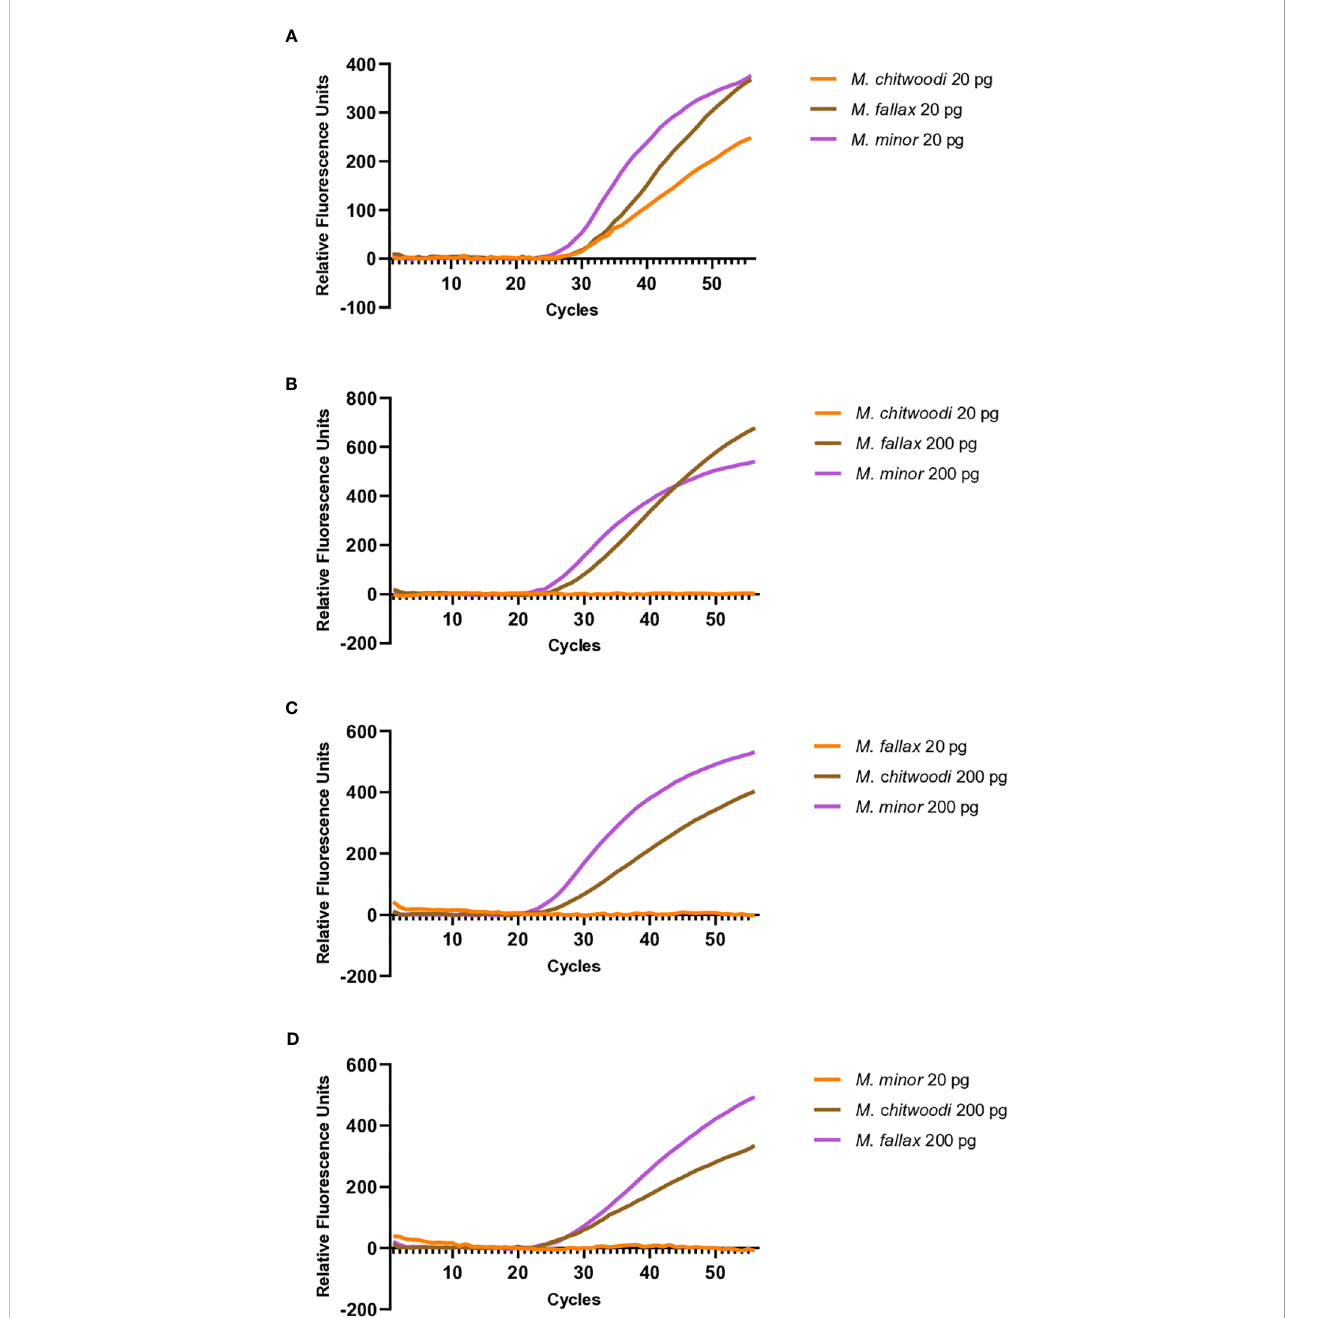
FIGURE 5 Multiplexed molecular beacon RT-PCR assays containing equal or unequal parts M. chitwoodi , M. fallax , and M. minor plasmid template. (A) Ampli fi cation curves from 20 pg of M. chitwoodi (average Ct = 31.3, SEM = 0.11, n = 6), M. fallax (average Ct = 30.9, SEM = 0.20, n = 6), and M. minor (average Ct = 30.1, SEM = 0.09, n = 6) in a single reaction (B) Ampli fi cation curves from 20 pg of M. chitwoodi (no ampli fi cation, n = 6), 200 pg M. fallax (average Ct = 26.8, SEM = 0.62, n = 6), and 200 pg M. minor (average Ct = 26.3, SEM = 0.39, n = 6) in a single reaction (C) Ampli fi cation curves from 20 pg of M. fallax (no ampli fi cation, n = 6), 200 pg M. chitwoodi (average Ct = 27.0, SEM = 0.50, n = 6), and 200 pg M. minor (average Ct = 25.1, SEM = 0.13, n = 6) in a single reaction. (D) Ampli fi cation curves from 20 pg of M. minor (no ampli fi cation, n = 6), 200 pg M. chitwoodi (average Ct = 26.6, SEM = 0.24, n = 6), and 200 pg M. fallax (average Ct = 26.6, SEM = 0.20, n = 6) in a single